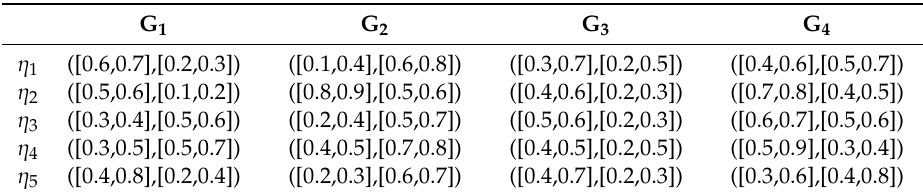
Table 2. The q-RIVOFNs information given by D 2 .